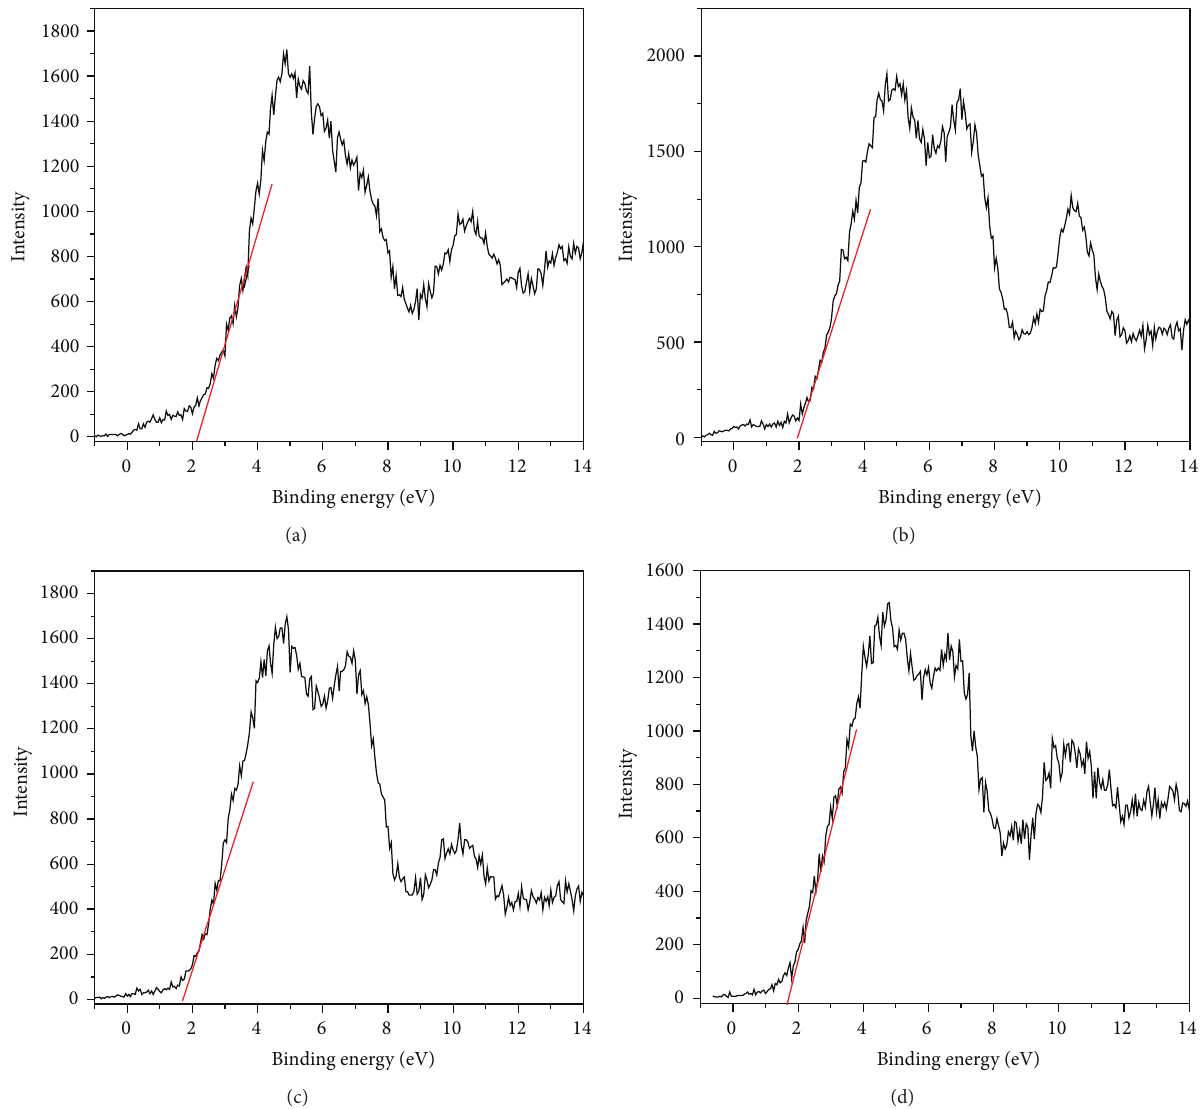
Figure 7: XPS spectra of the TiO 2 thin film at the valence band region, annealing at 400 (a), 500 (b), 600 (c), and 700 ∘ C (d) for 6 hours in oxygen atmosphere,